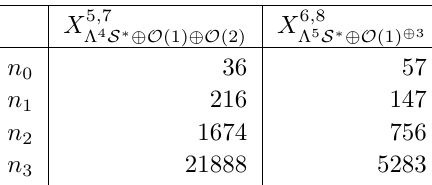
Table 6 . The triple intersection number and instanton numbers for CY 3-folds in Gr(5 ; 7) and Gr(6 ;